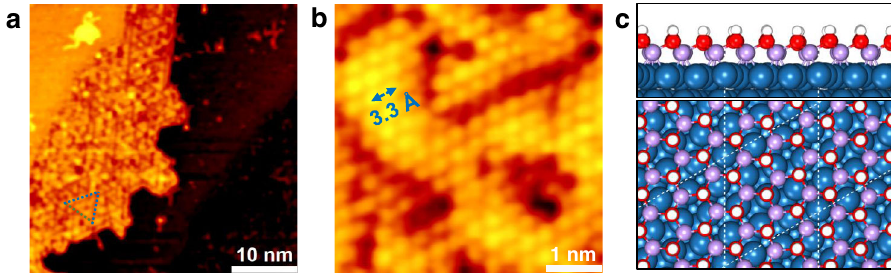
Fig. 3 | Structure of the hydroxylated Mn oxide surface. a STM image of a hydroxylatedsurface. b Atomic-resolutionSTMimageofthehydroxylatedsurface. Scanning parameters: ( a ) I t =0.100nA, V s =0.999V; ( b ) I t =0.210nA, V s